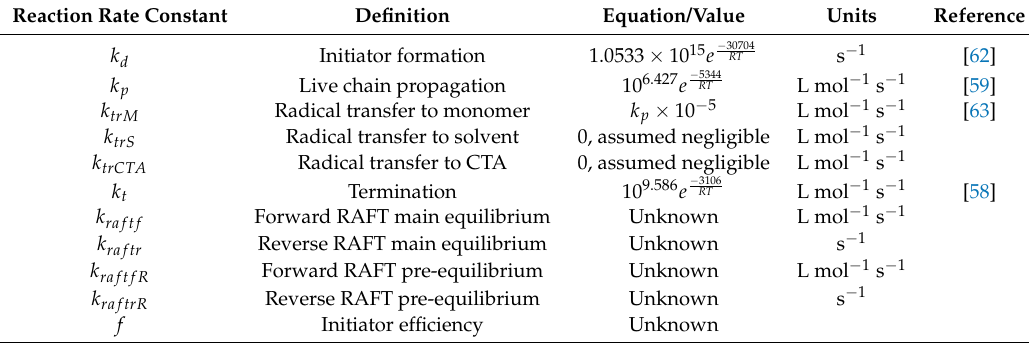
Table 3. Reaction rate constant